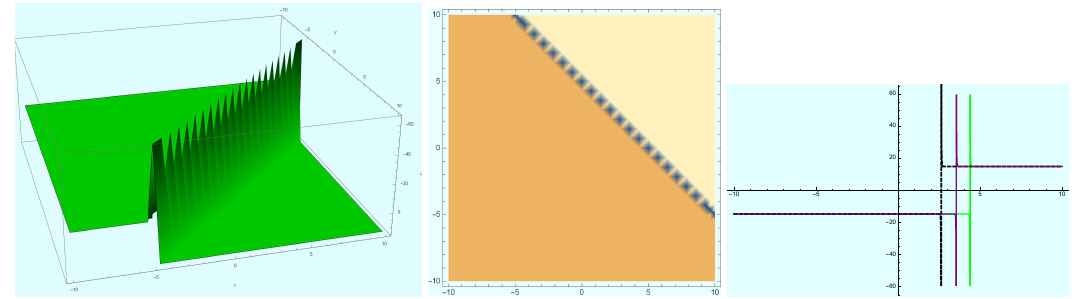
Figure 4. Evolution of traveling wave of singular soliton solution (24) at t = 1 and z = 0.